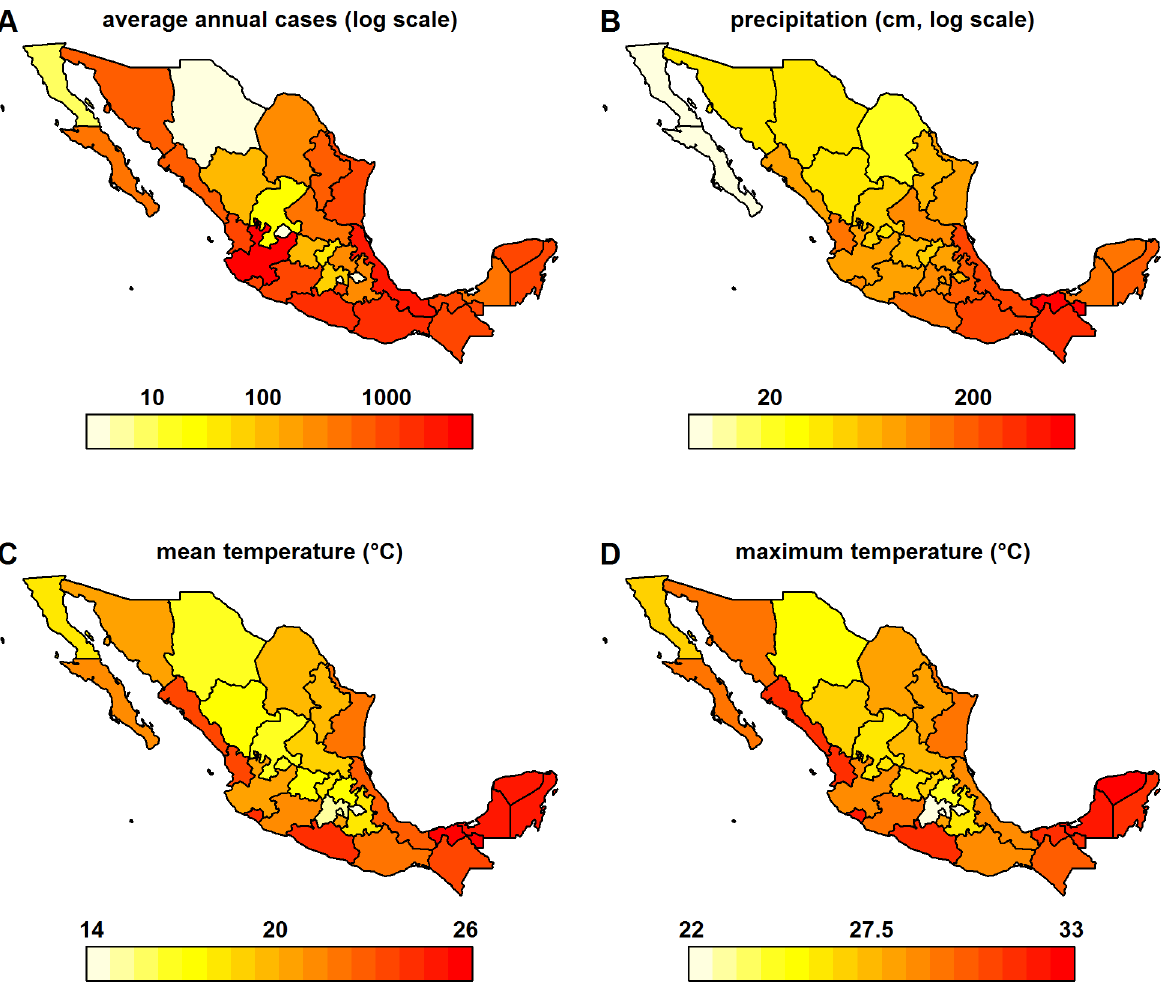
Figure 3. Geographic variation of state-level covariates. The covariates most highly associated with GDT accuracy (Table 1) were average annual dengue cases (A), average annual precipitation (B), mean temperature (C) and maximum temperature (D).